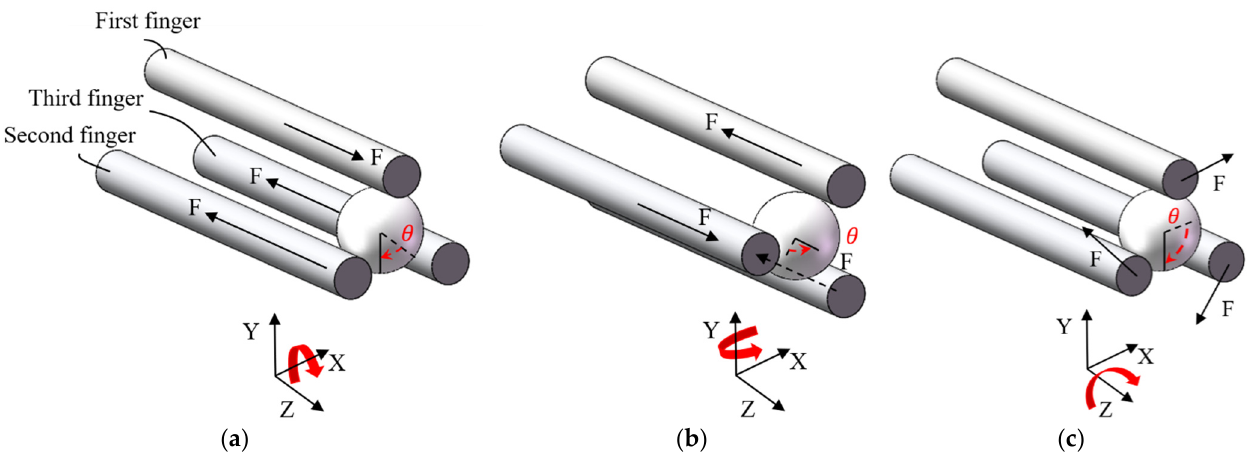
Figure 17. Rotations of micro object with the microgripper: ( a ) Rotation about axis X, ( b ) Rotation about axis Y, and ( c ) Rotation about axis Z.